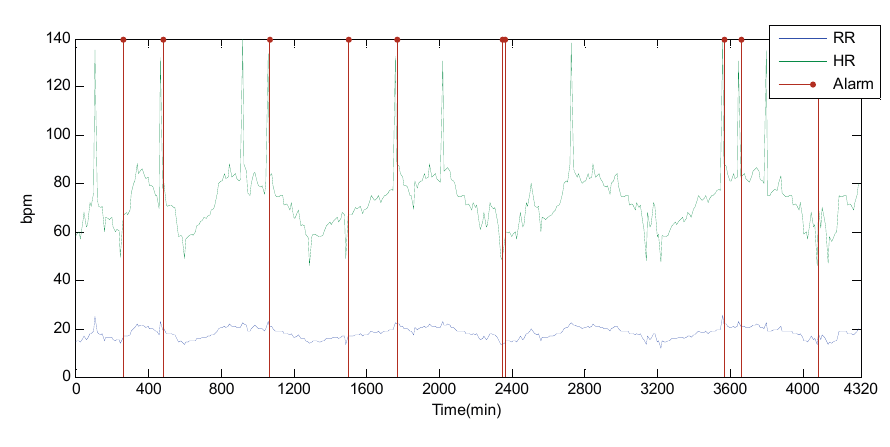
Figure 9. Undetected alarms.